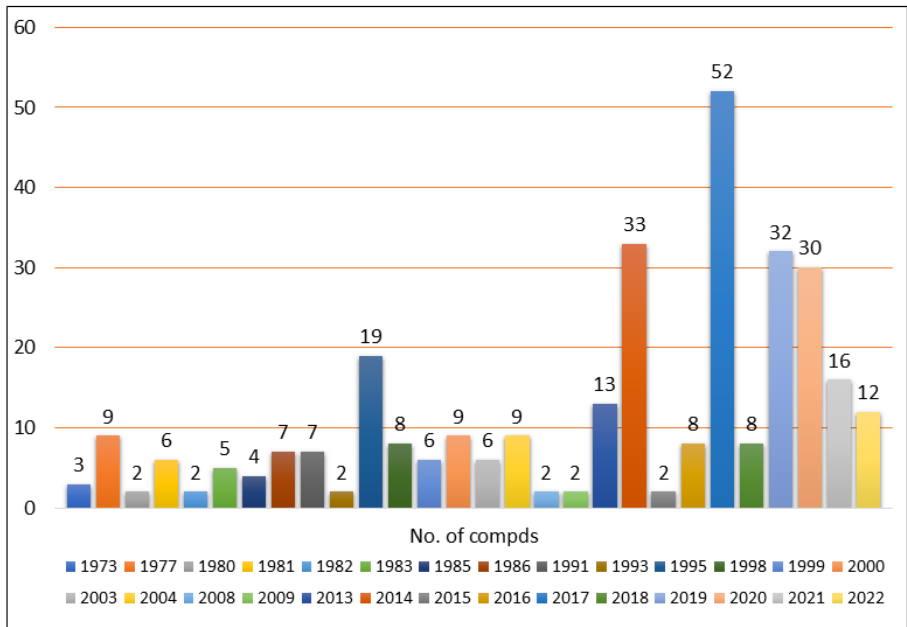
Figure 27. Number of metabolites per year reported from S. chartarum.